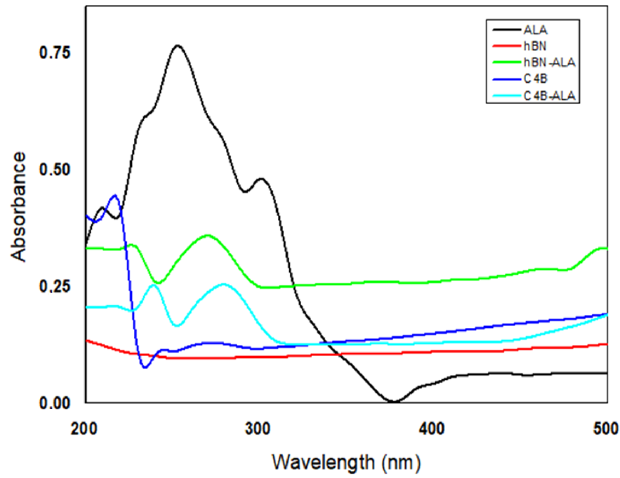
Figure 1. UV-vis spectrum of hBN, B 4 C, hBN-ALA, B 4 C-ALA, and Figure 1. UV ‐ vis spectrum of hBN, B 4 C, hBN ‐ ALA, B 4 C ‐ ALA, and ALA.